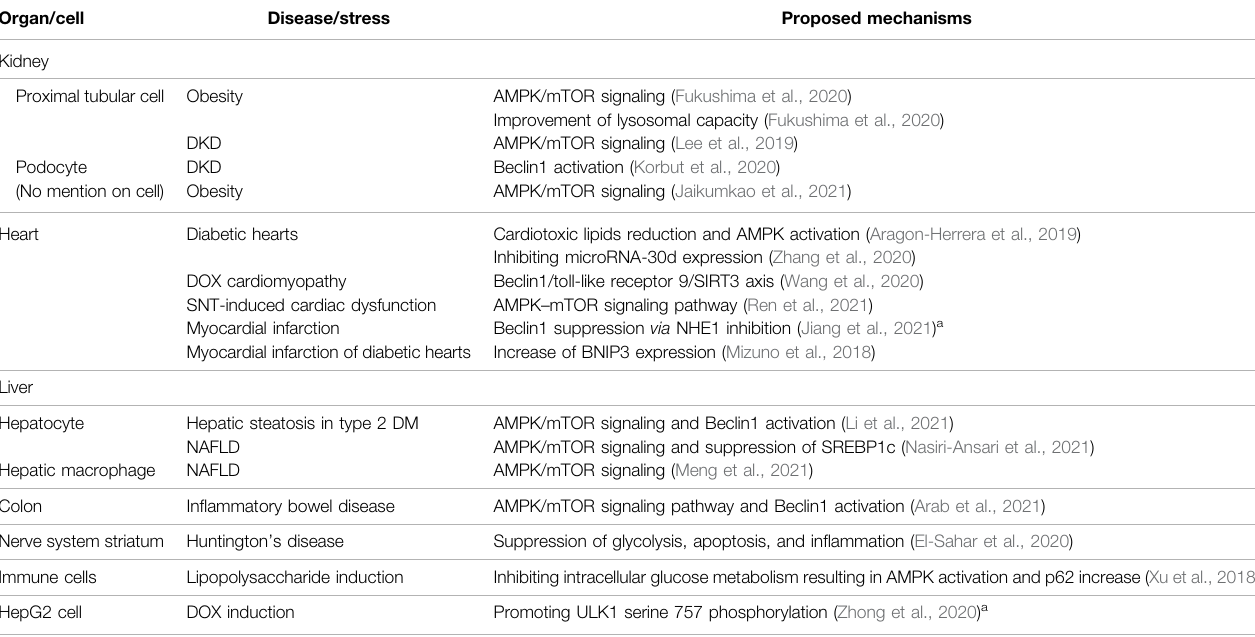
TABLE 1 | Proposed effects of SGLT2 inhibitors on autophagy de fi ciency in each organ/cell and disease. Organ/cell